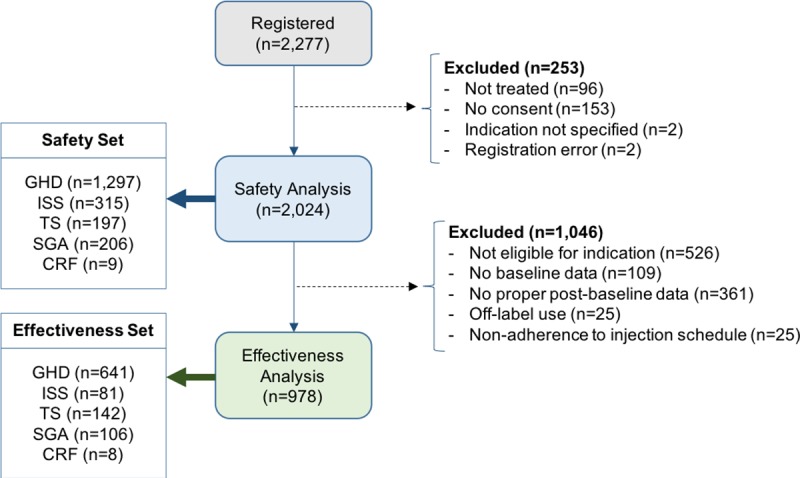
Disposition of patients.